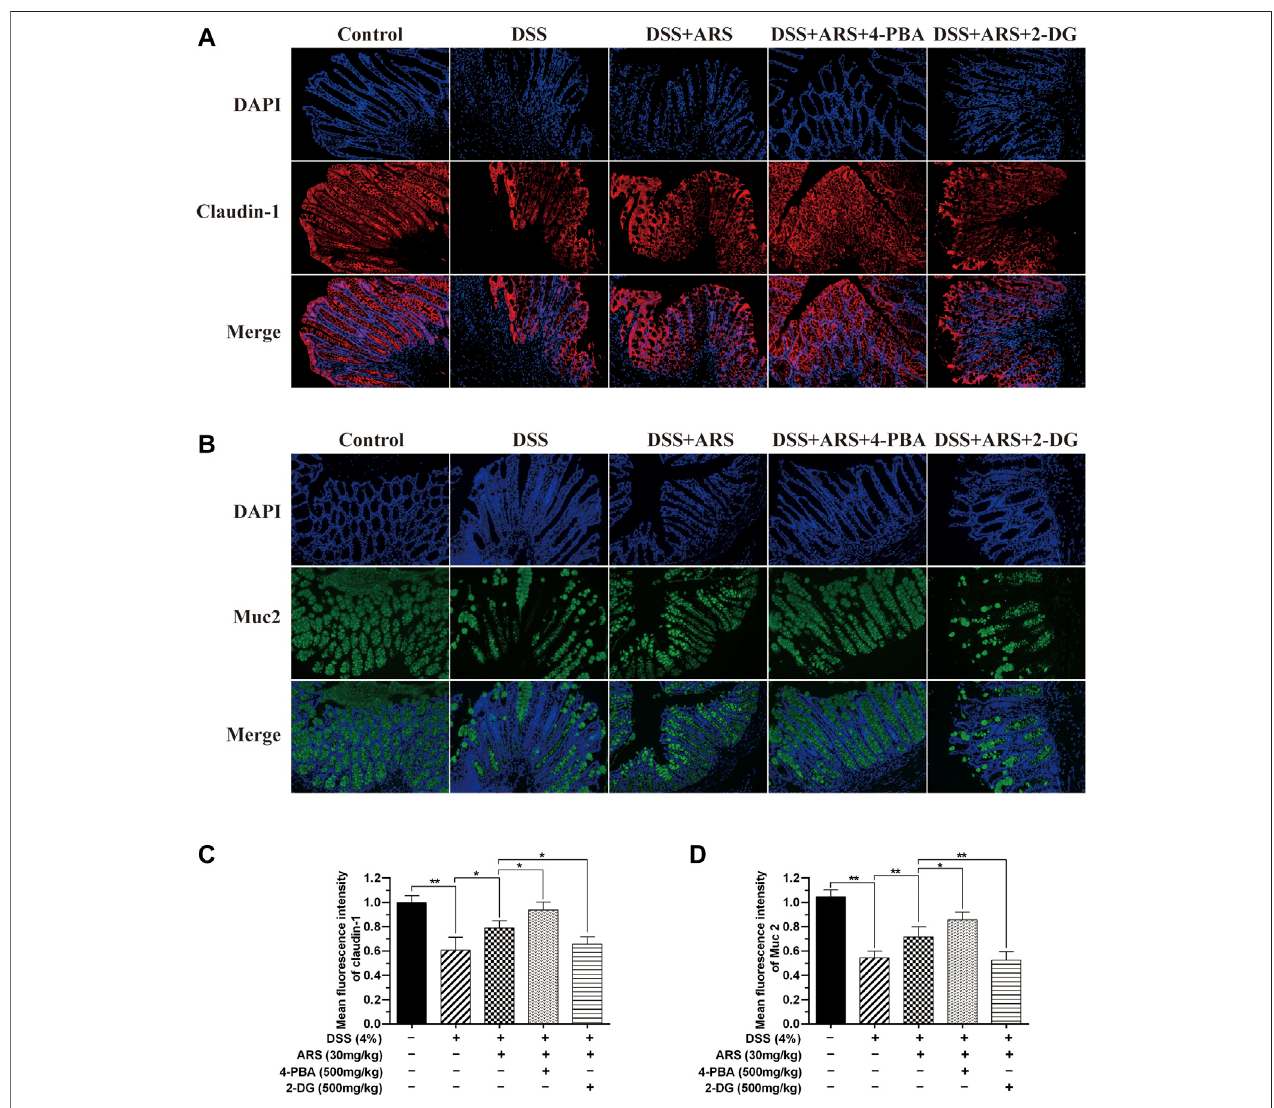
FIGURE 7 | The inhibitory effect of ARS on ER stress involves in maintaining intestinal barrier integrity. Sections of colonic tissues were immunostained with DAPI and antibodies and then observed under 200 × fl uorescence microscope. The red fl uorescence represents the amount of claudin-1 (A) , The green fl uorescence represents the amount of Muc2 (B) . The blue fl uorescence is the nucleus stained by DAPI. (C) Quanti fi ed results from (A) . (D) Quanti fi ed results from (B) . Data are presented as mean ± SD ( n (cid:1) 3). * p < 0.05, ** p < 0.01.